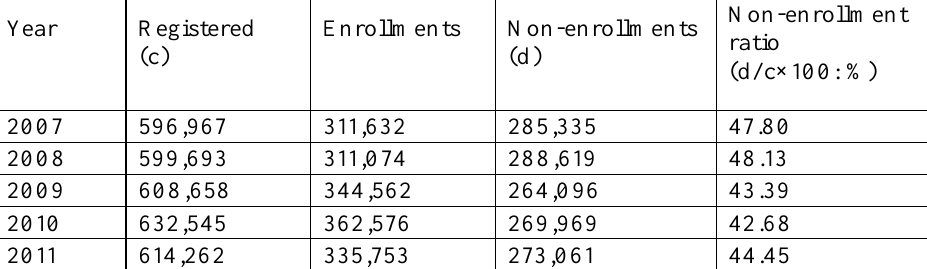
Non-Enrollment Rates at KNOU between 2007 and 2011